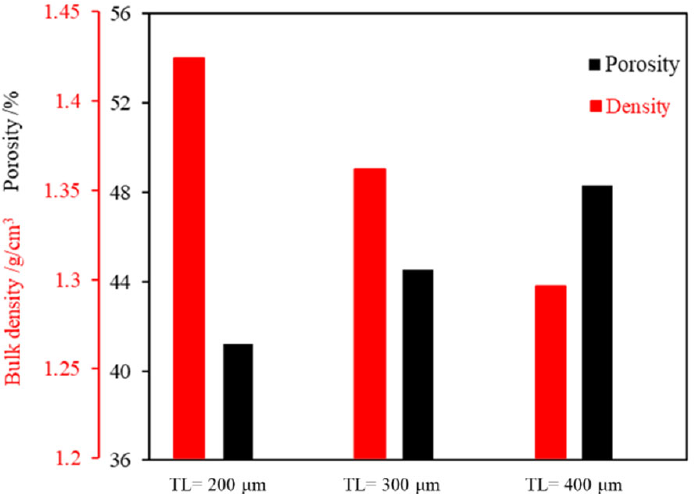
Figure 8. Comparison of porosity and density of the 3DP rocks printed with different LTs.